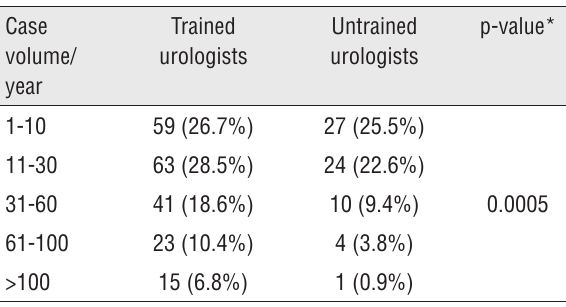
Table 2 - case volume per year for the trained and nontrained